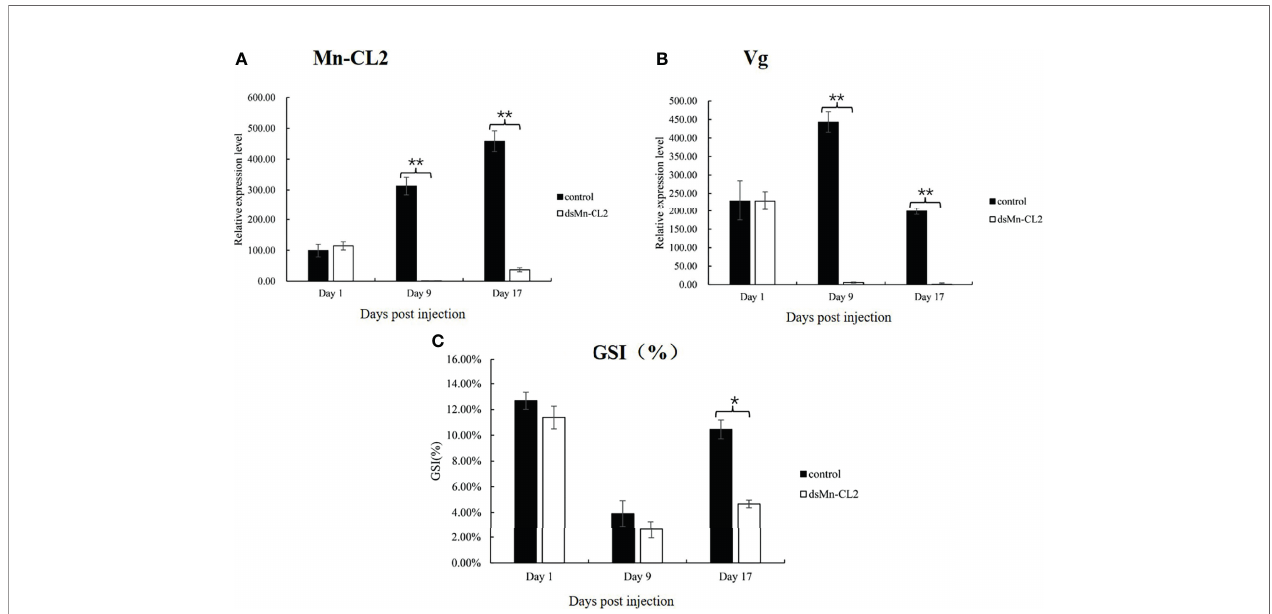
FIGURE 7 | Function analysis of Mn-CL2 by RNAi. (A) Ef fi ciency of RNAi- Mn-CL2 knockdown in ovary. (B) Vg transcript after Mn-CL2 dsRNA injection. (C) Changes in GSI (%) of female M. nipponense after injection with Mn-CL2 dsRNA. Data are presented as mean ± SD (n = 6); *denotes statistical signi fi cance of P < 0.05. **denotes statistical signi fi cance of P <